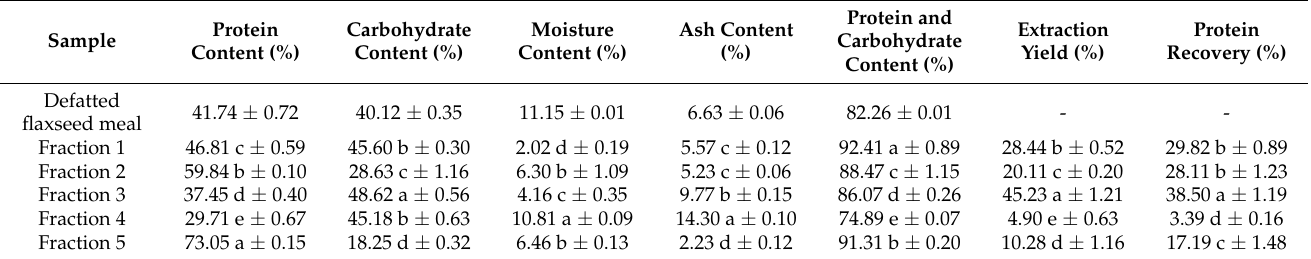
Table 1. Composition, extraction yield, and protein recovery of defatted flaxseed meal and protein- polysaccharide natural fractions at a dry basis. Comparisons were performed between values of the same serious and those without same letter(s) differed significantly at p <